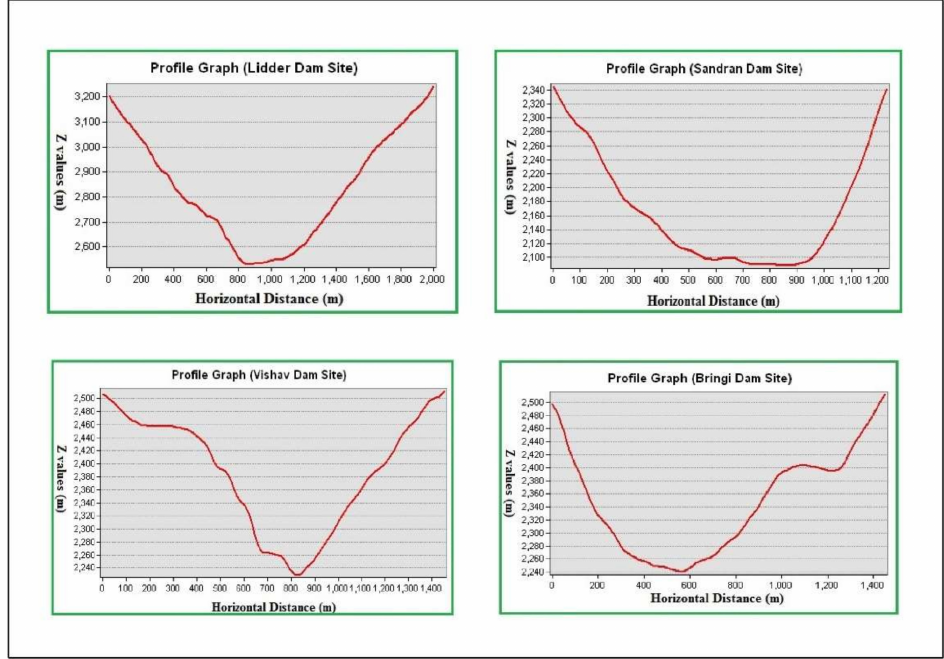
Figure 7. Profile graphs of the selected dam